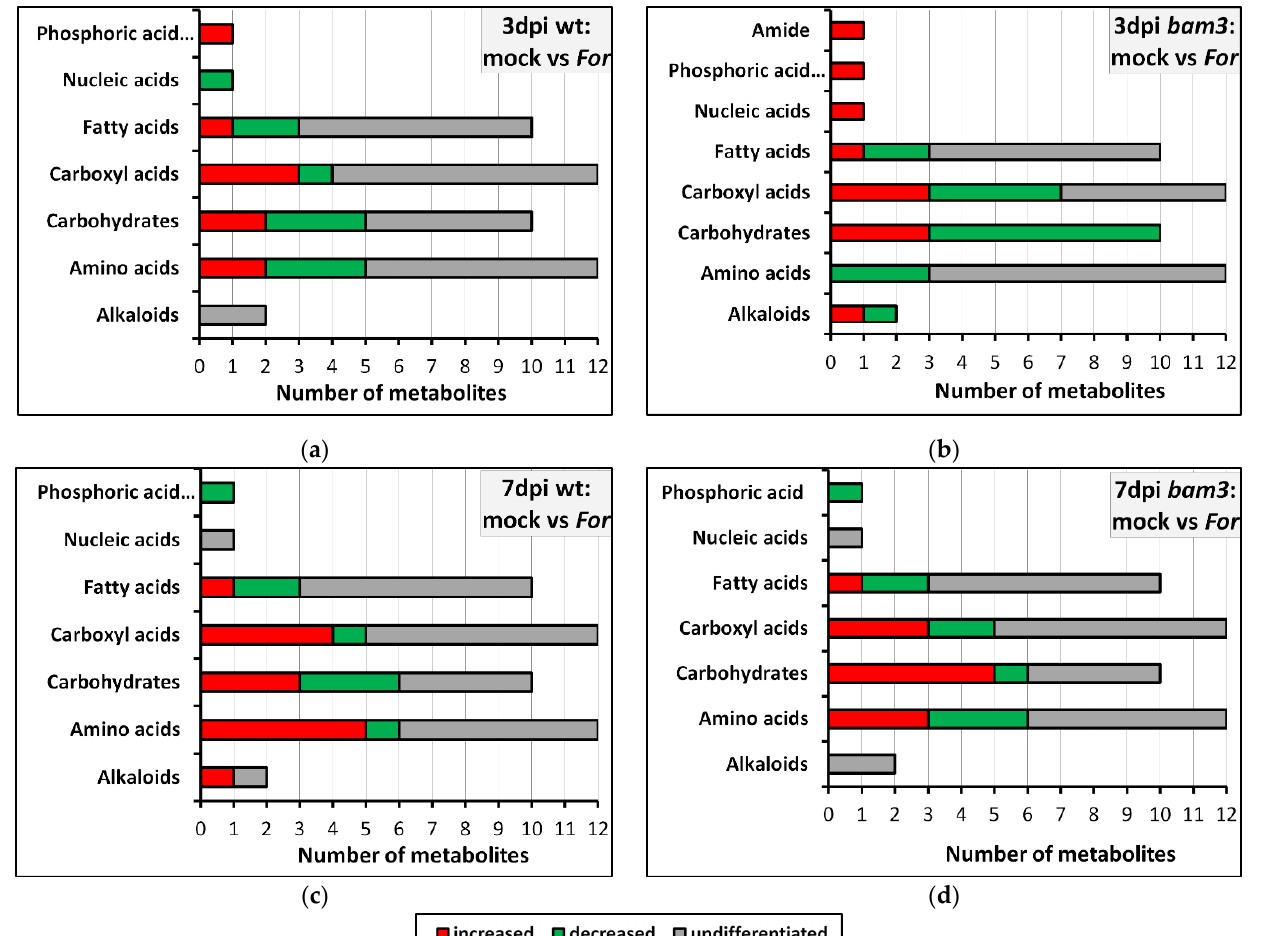
Figure 4. Classification of Arabidopsis thaliana wt and bam3 metabolites into chemical groups in response to Fusarium oxysporum f. sp. raphani (For) inoculation. The total number of signatory metabolites, classified into increased, decreased, and undifferentiated in wt ( a , c ) and bam3 ( b , d ) For -inoculated plants compared to mock plants at three ( a , b ) and seven ( c , d ) days post inoculation (dpi), are presented in the above graphs. For the chemical classification of metabolites, information was retrieved from the PubChem